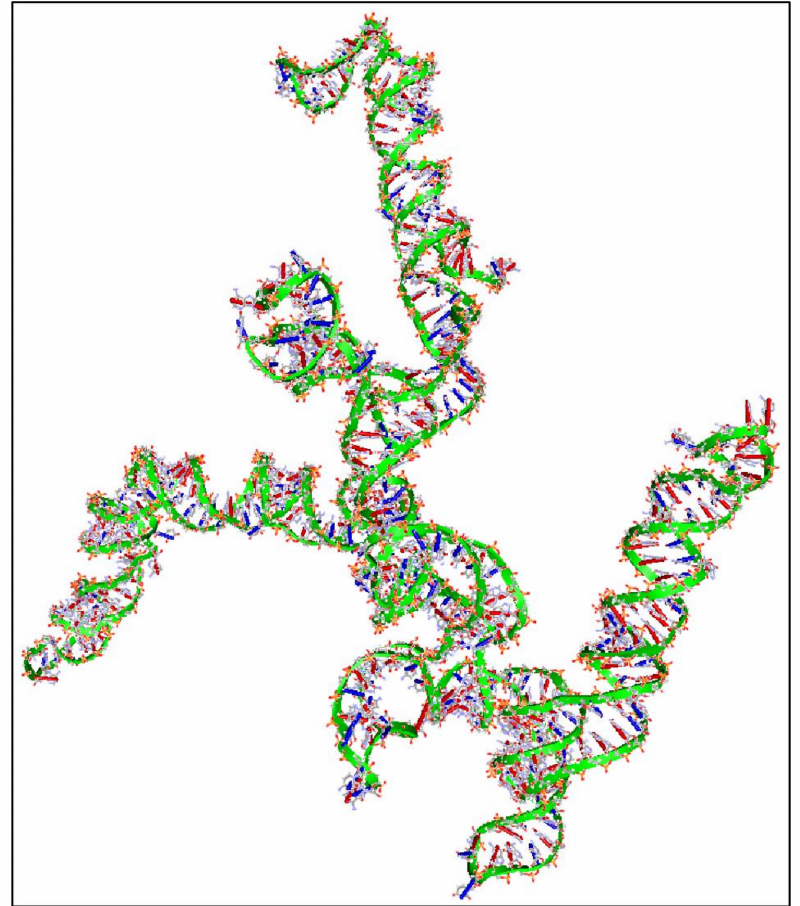
Figure 9. The predicted 3D structure of the MYCN , NM001293228 transcript and in particular, of the first exon (Nucleotides 1–504) (3D structure was predicted using the RNAcomposer web-tool [87,88] and it was then visualized using the Accelrys Discovery